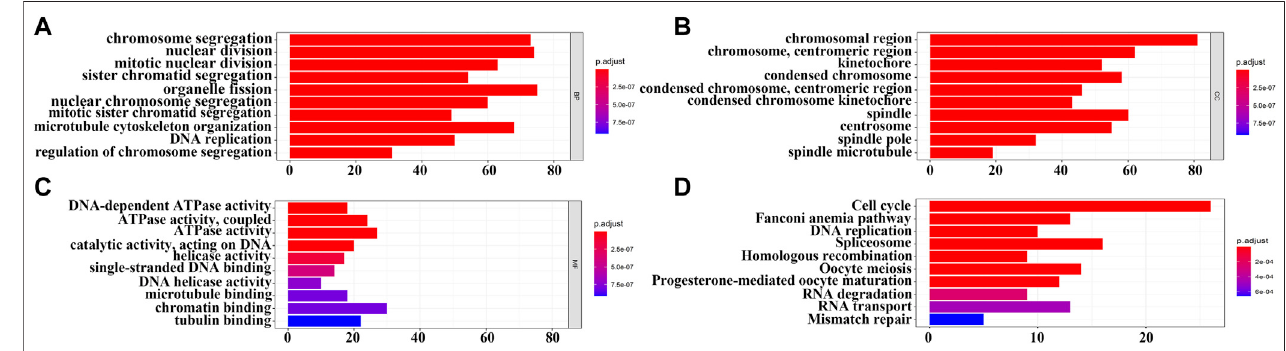
FIGURE 7 | Biological functions and signaling mechanisms of genes co-expressed with SPDL1 were determined via GO and KEGG analysis. (A) BP; (B) CC; (C) MF;and (D) KEGG.BP,biologicalprocesses;MF,molecularfunctions;CC,cellularcomponents;KEGG,Kyotoencyclopediaofgenesandgenomes;ESCA,esophageal cancer; SPDL1, spindle apparatus coiled-coil protein 1.